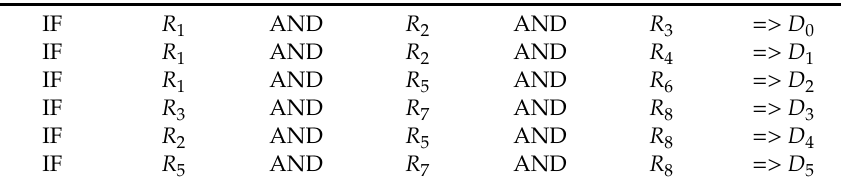
Table 5. Inference of the diagnostic